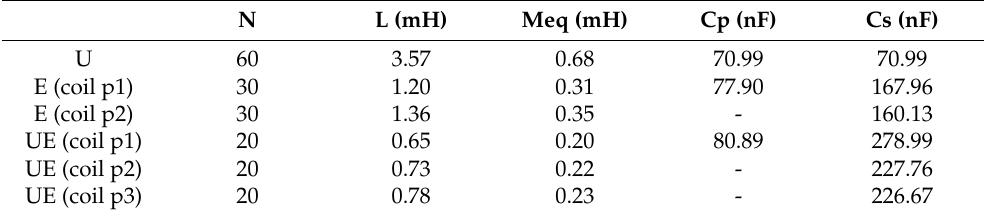
Table 1. Simulation parameters of U-shaped, E-shaped, and UE-shaped magnetic coupling structures.